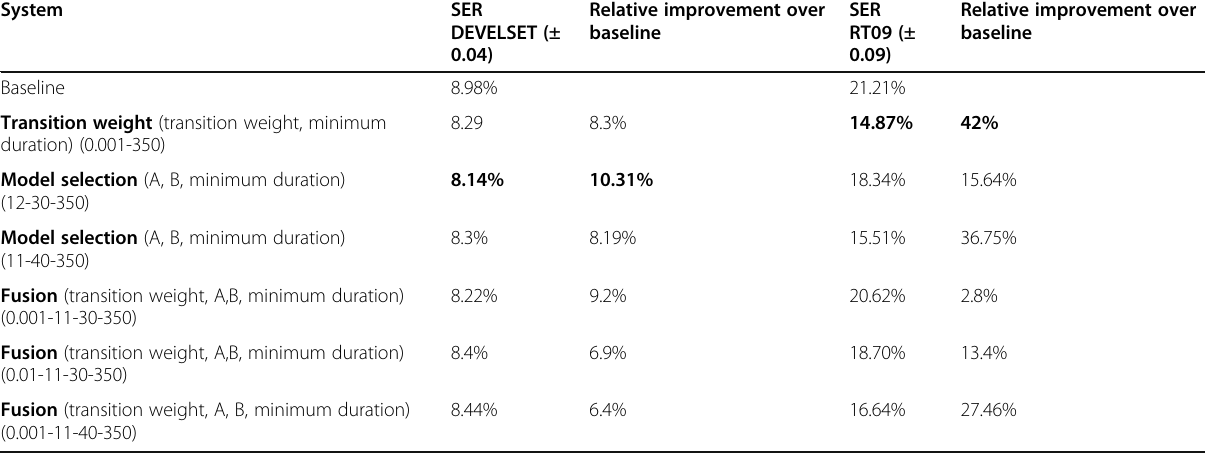
Table 10 Results using a single mfcc stream and all the proposed methods System